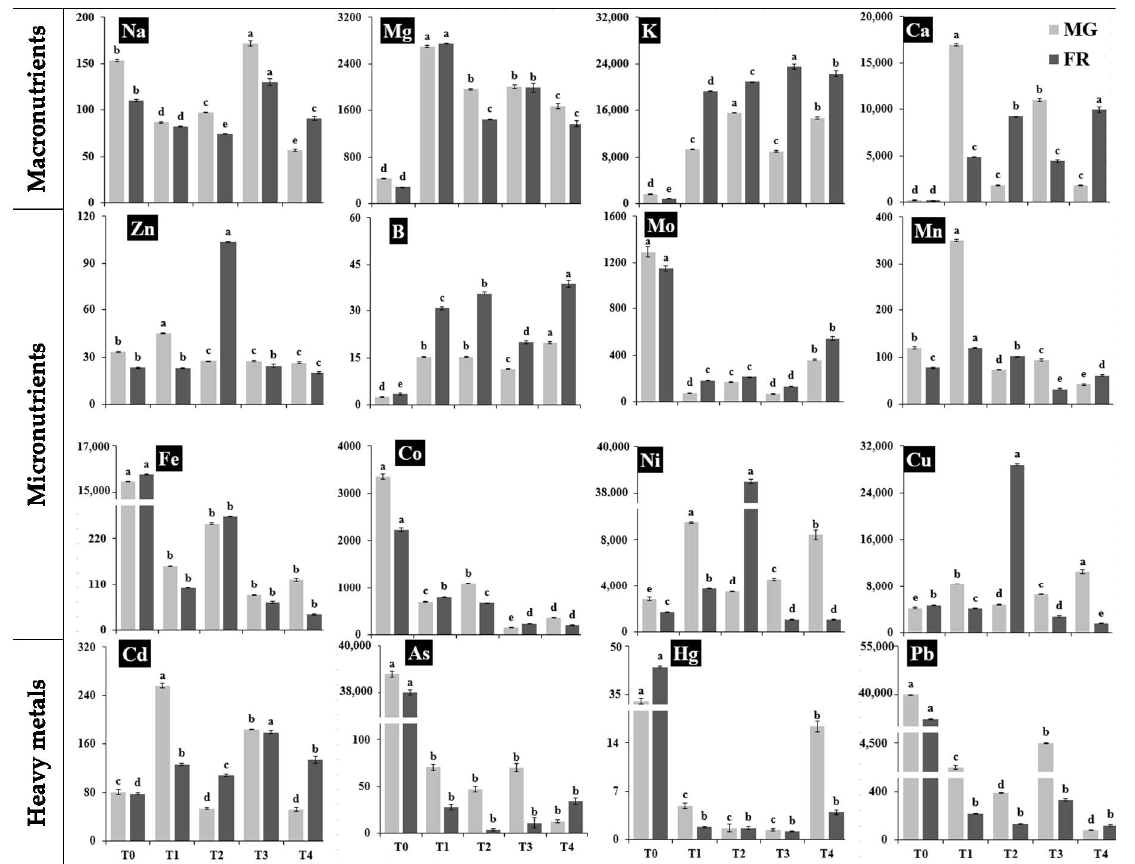
Figure 1. Level of mineral nutrients and heavy metals in the leaves of a loquat as affected by the exogenous application of Mg, Zn, and B. Different letters indicate a significant difference among treatments for each series according to Fisher’s least significant difference test at α = 0.05. Vertical bars indicate average ± standard error (four replicates, p ≤ 0.05). T 0 —control; T 1 —2% MgSO 4 .7H 2 O, T 2 —0.1% ZnSO 4 .7H 2 O, T 3 —0.2% Na 2 B 4 O 7 .10H 2 O and T 4 —T 1 +T 2 +T 3 (1:1:1), MG—mature green stage, FR—fully ripe stage.